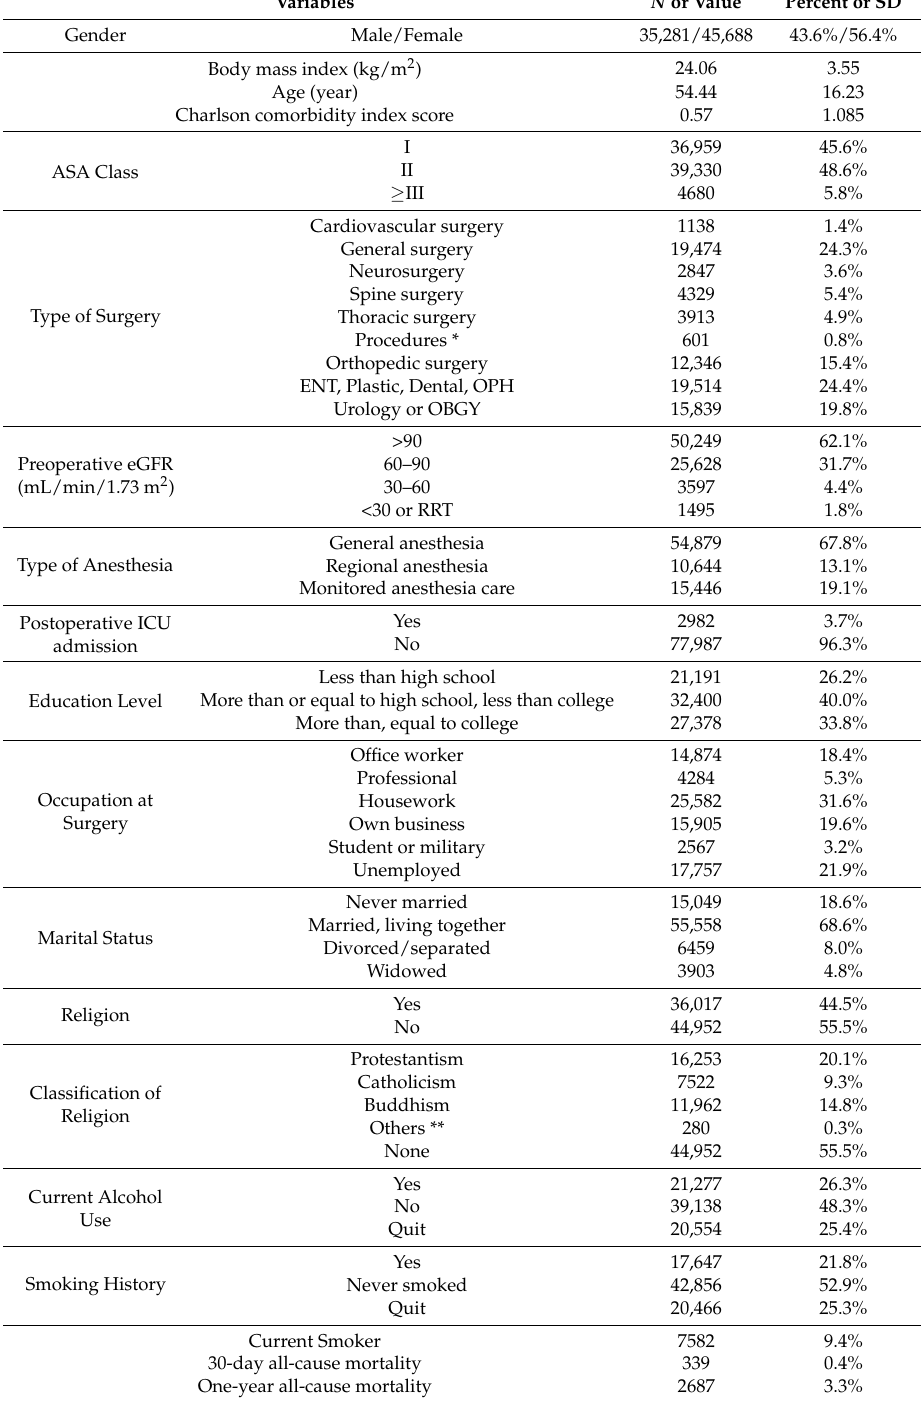
Table 1. Baseline characteristics of the total study